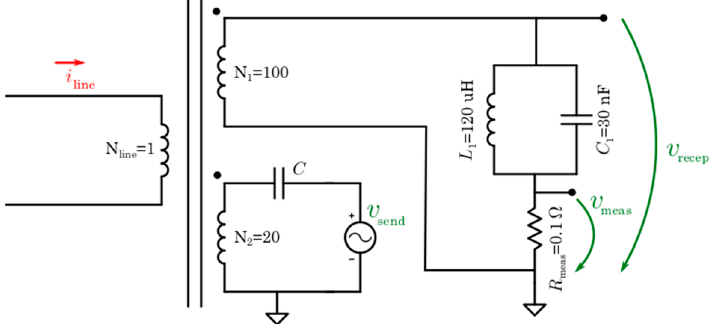
Figure 8. Communication-measurement connection.